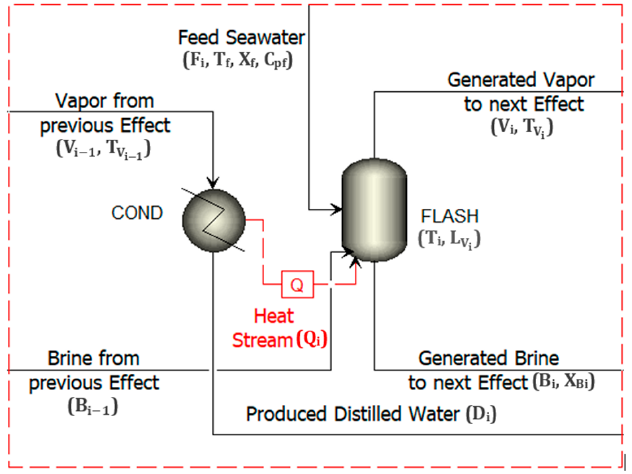
Figure 3. Modules that are used to simulate the MED Effect in Aspen Plus.